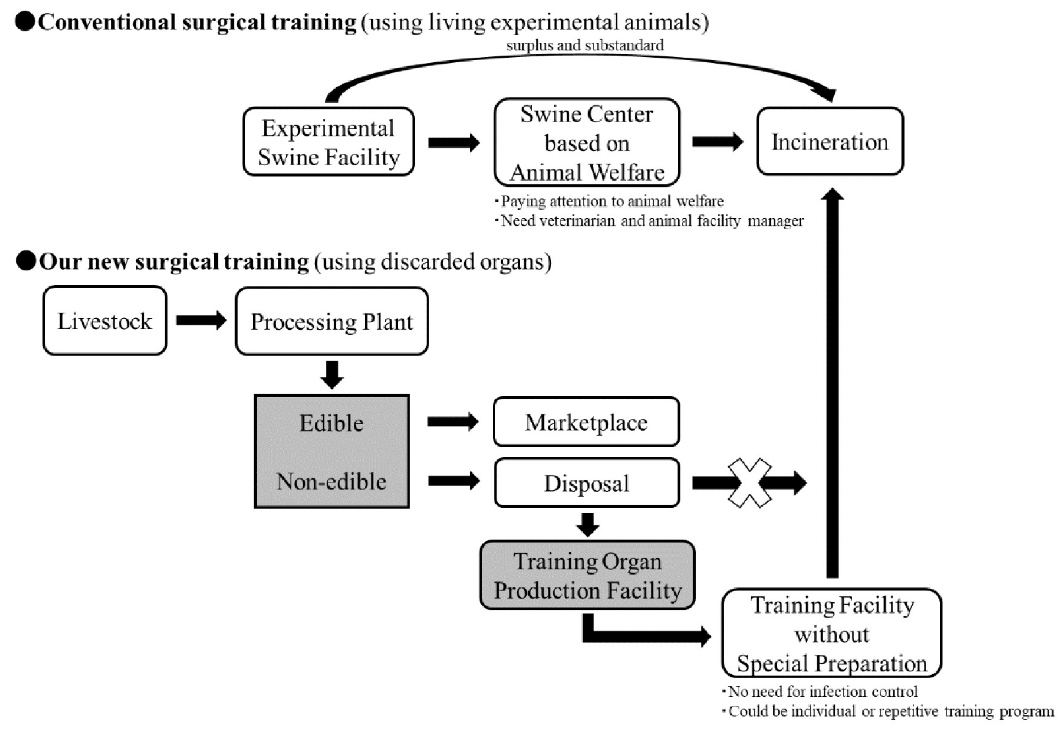
Fig 7. Concept of our new surgical training model. Standard advanced surgical training was performed using a living experimental animals, and multiple trainings are required to master the technique. Therefore, many living experimental animals was necessary. However, our new concept was recycled the waste organs at meat processing plants for surgical training materials, and it was possible to significantly reduce the number of the living experimental